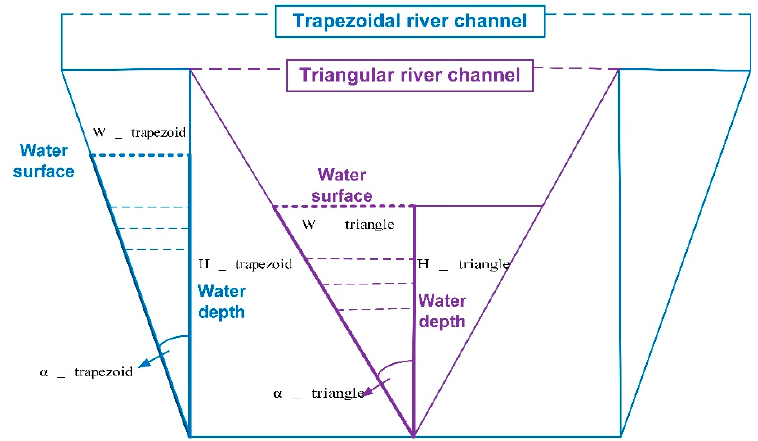
Figure 5. Sketch map of the relationship between the river water depth and the width of the water surface for triangular or trapezoidal river cross-sections.